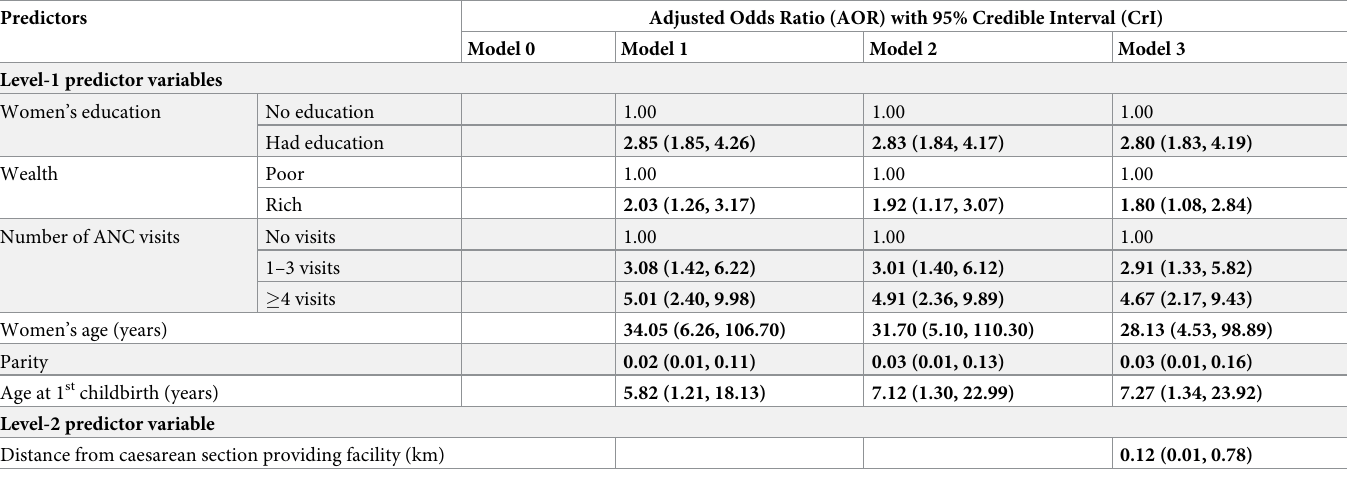
Table 1. Factors associated with caesarean delivery use among pregnant women in Ethiopia,